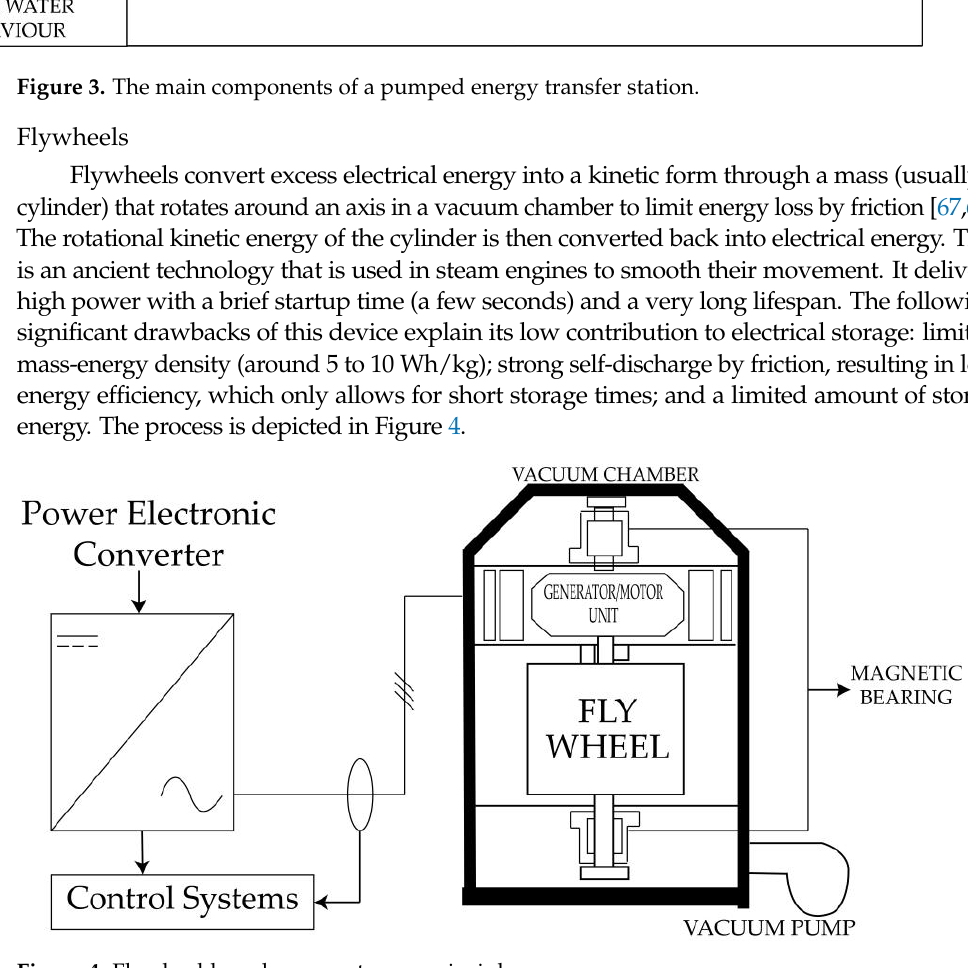
Figure 4. flywheel-based energy storage principle. Figure 4. Flywheel-based energy storage